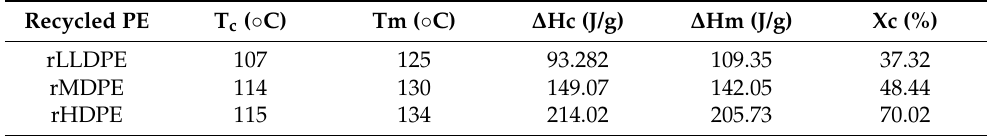
Table 5. Results of residual metal additives in recycled PE plastics (LLDPE, MDPE, and HDPE).